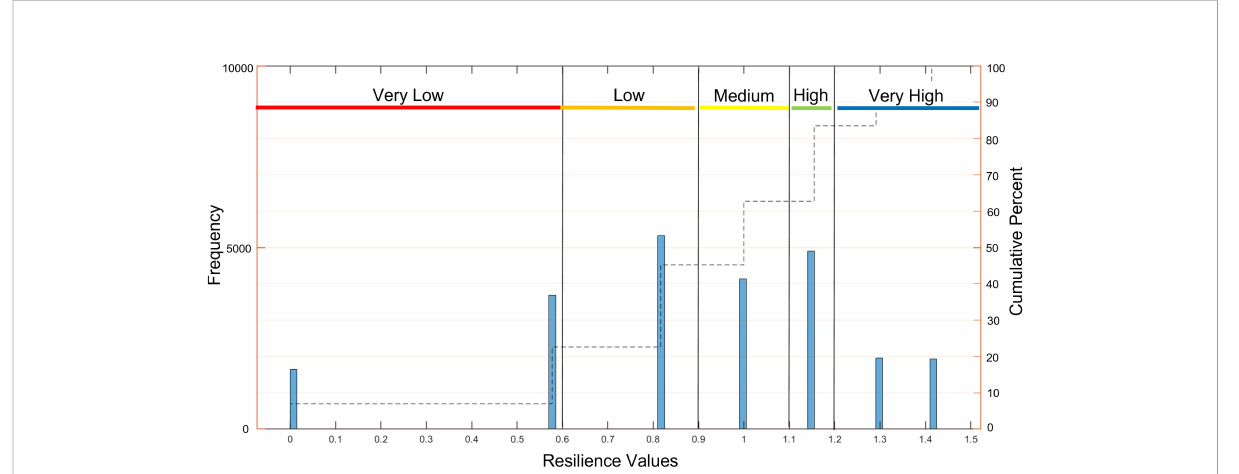
FIGURE 7 Frequency of occurrence expressed in histograms and cumulative percent of the CVIfRS values for the Yucatan coast. Color lines show the range between categories, Very Low (red), Low (orange), Medium (yellow). High (green) and Very High